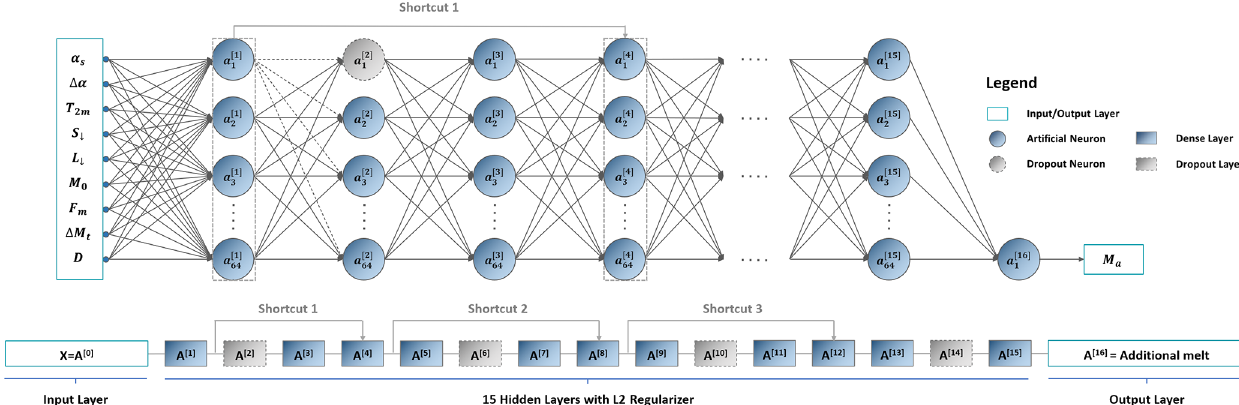
Figure 3. Overview of the built deep multilayer perceptron (MLP) model architecture; the input parameters are the simulated albedo ( α s ) itself, the albedo difference ( (cid:49)α ≡ α o − α s ) between the observed ( α o ) and simulated albedo, air temperature at 2m ( T 2m ), incoming short- wave radiation ( S ↓ ), downwelling longwave radiation ( L ↓ ), simulated surface melt ( M 0 ), Boolean melt flag ( F m ), surface melt difference to the previous day ( (cid:49)M t ), and record date as day of the year ( D